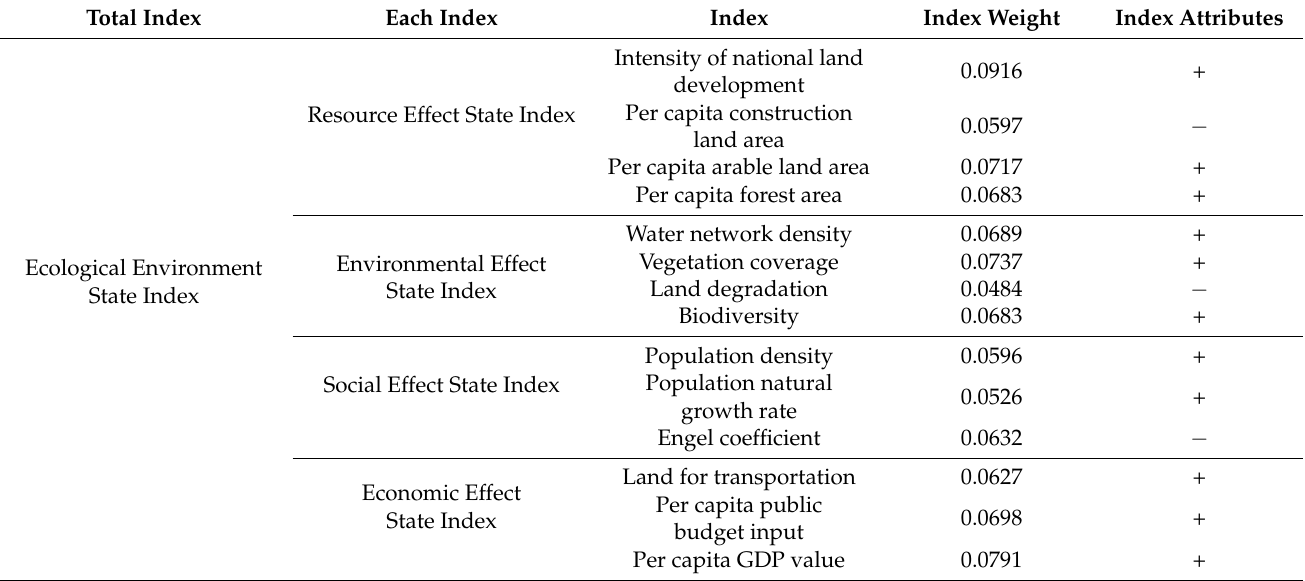
Table 1. Evaluation index system of the ecological environmental effect of land